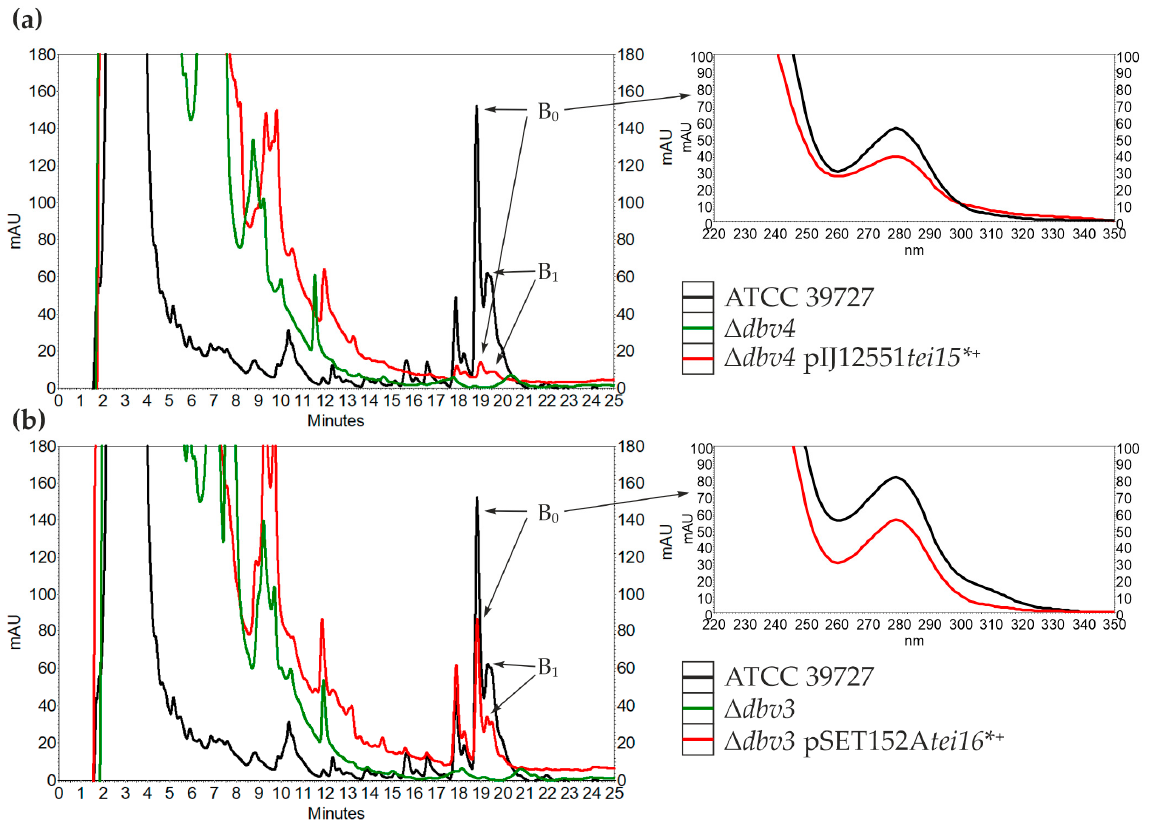
Figure 4. HPLC analysis showing the restoration of A40926 production in N . gerenzanensis Δ dbv4 pIJ12551 tei15* + ( a ) and Δ dbv3 pSET152A tei16* + ( b ). N . gerenzanensis strains were cultivated for 144 h in FM2; A40926 was extracted as described in Materials and Methods and the extracts from Δ dbv4, Δ dbv4 pIJ12551 tei15* + , Δ dbv3 , and Δ dbv3 pSET152A tei16* + were concentrated ten times by lyophi- lization. Peaks with a typical UV spectrum, corresponding to A40926 B 0 and B 1 (indicated by black arrows), were clearly visible in the control N . gerenzanensis ATCC 39727 (black). In ( a ), A40926 B 0 and B 1 were detectable, although at a very low level, in the concentrated extracts from N . gerenzanen- sis Δ dbv4 pIJ12551 tei15* + (red ) , but not in those from N . gerenzanensis Δ dbv4 (green). In ( b ), A40926 B 0 and B 1 were detectable in Δ dbv3 pSET152A tei16* + concentrated extracts (red) but were undetectable in those from N . gerenzanensis Δ dbv3 (green) (for the chromatogram of commercial A40926 standard please refer to Figure S2a).